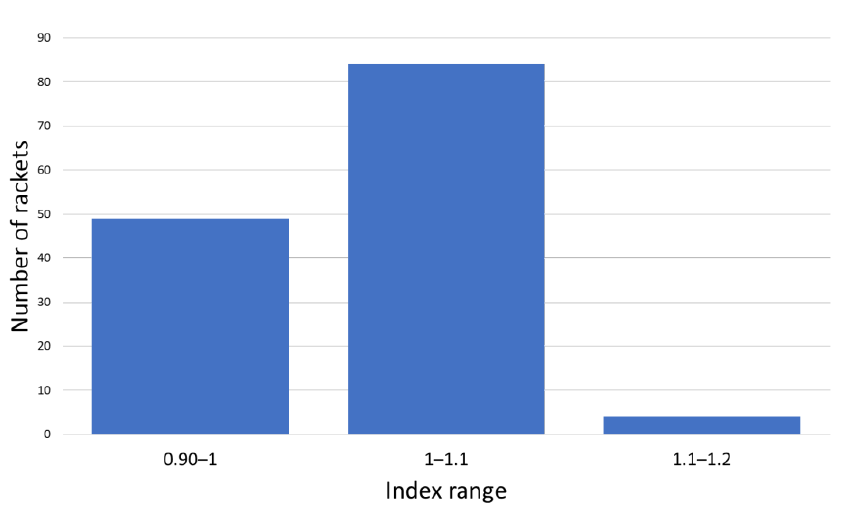
Table 8. Results of the test with users. Each value represents the percentage of users classifying the racket in the category.